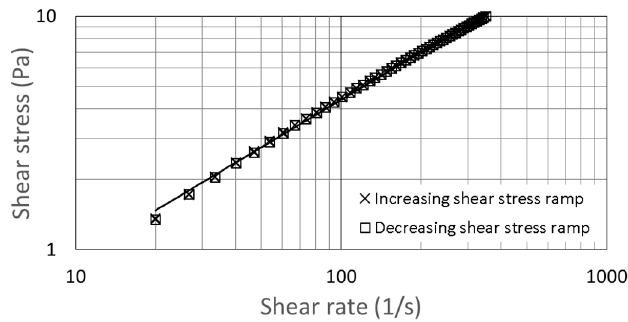
Figure 2. Rheogram corresponding to the water- sodium carboxymethyl cellulose (CMC) solution used in Experiment 13. The solid line is the best fitting curve to the measurements, given by 𝜏 = 0.194𝛾(cid:4662) (cid:2868).(cid:2874)(cid:2875)(cid:2876) , with a correlation coefficient 𝑅 (cid:2870) = 0.99834 .